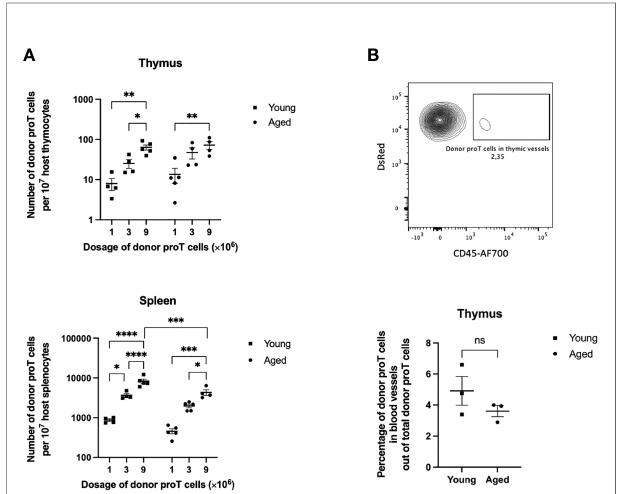
FIGURE 1 | Thymus engraftment by in vitro -generated progenitor T cells in unmanipulated young and old mice. (A) CD25 + DsRed + donor proT cells per 10 7 host thymocytes (top) and splenocytes (bottom) isolated from host thymuses and spleens of non-irradiated aged and young mice. Each group of mice (n=4-5) were injected with 1, 3, or 9 x10 6 proT cells. Error bars depict SEM; * p <0.05, **p<0.01, ***p<0.001, ****p<0.0001 analyzed by two-way ANOVA. (B) Representative fl ow cytometric analysis of detected DsRed + proT cells from the thymus of a host mouse (top). Aggregated percentages of DsRed + proT cells in blood vessels out of total DsRed + proT cells from host thymuses injected with either 1, 3, or 9 x10 6 proT cells (bottom). Hosts were intravenously injected with CD45-AF700 antibodies 3 minutes prior to sacri fi cing. Error bars depict SEM; difference between the aged and young mice groups was not signi fi cantly (ns) different as analyzed by two tailed unpaired student ’ s t